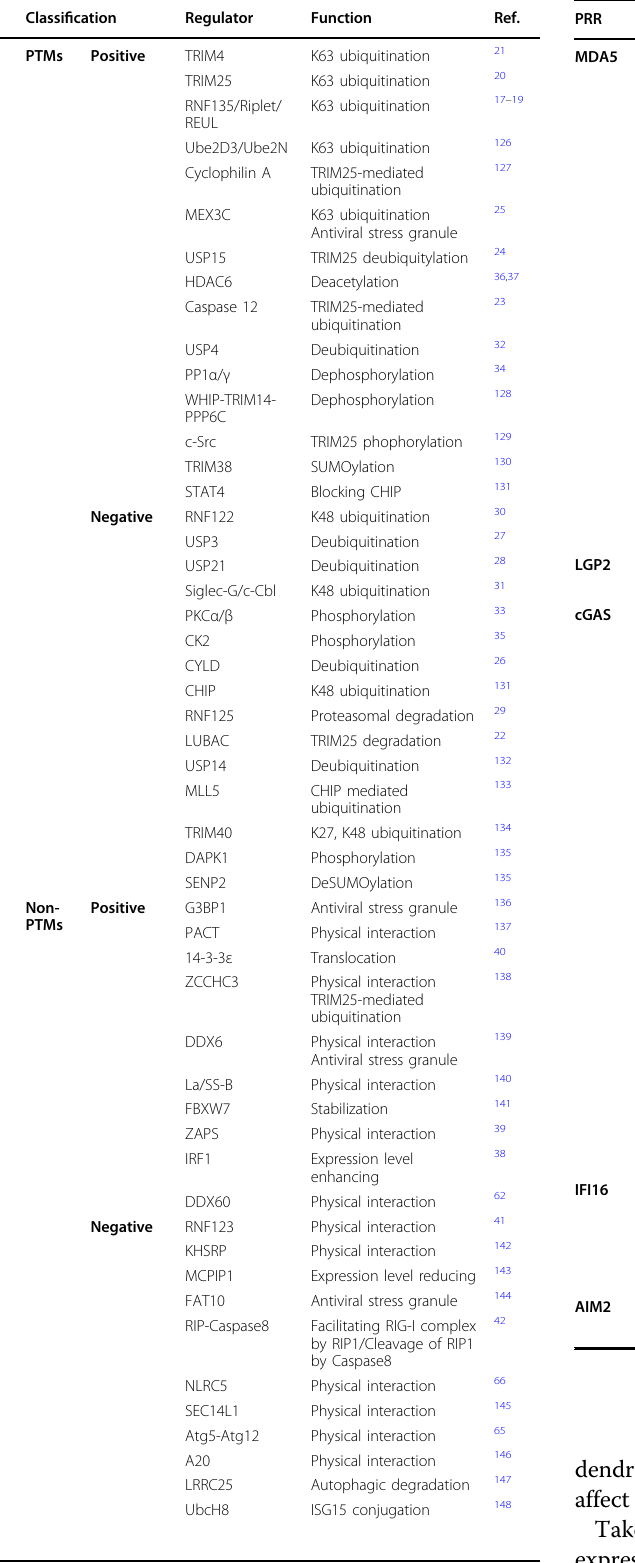
Table 2 Regulators for RNA and DNA virus